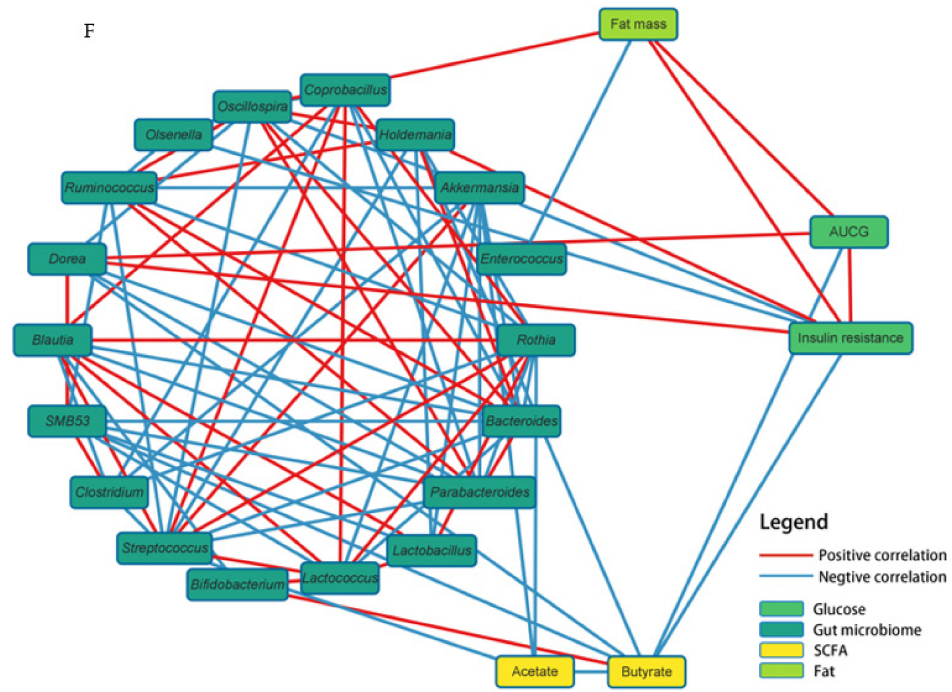
Figure 5. Short-chain fatty acid (SCFA) concentrations and fecal bacteria composition. ( A ). SCFA concentrations in the blood from the portal vein. ( B ). Relative abundance of fecal bacteria from the cecum at the family level. ( C ). Relative abundance of fecal bacteria from the cecum at the genus level. ( D ). β -diversity of fecal bacteria. Colored circles indicated the separation of each group by the assigned color in each group. ( E ). Linear discriminant analysis (LDA) scores in Lefse analysis at the genus level. ( F ). A network analysis of visceral fat, glucose intolerance, insulin resistance, SCFA, and gut microbiota. The correlation coefficient > 0.4 and p < 0.0001. SCFA, short-chain fatty acids; AUCG, the area of serum glucose concentration during the oral glucose tolerance test; Fat mass, visceral fat mass. Bars and error bars represent the means ± standard deviations ( n = 10). HBLB, the rats fed TMK with high contents of Bacillus spp. and high biogenic amines; HBHB, the rats fed TMK with high contents of Bacillus spp. and low biogenic amines; LBHB, the rats fed TMK with low contents of Bacillus spp. and high biogenic amines; LBLB, the rats fed TMK with low contents of Bacillus spp. and low biogenic amines. a–c Different letters on the